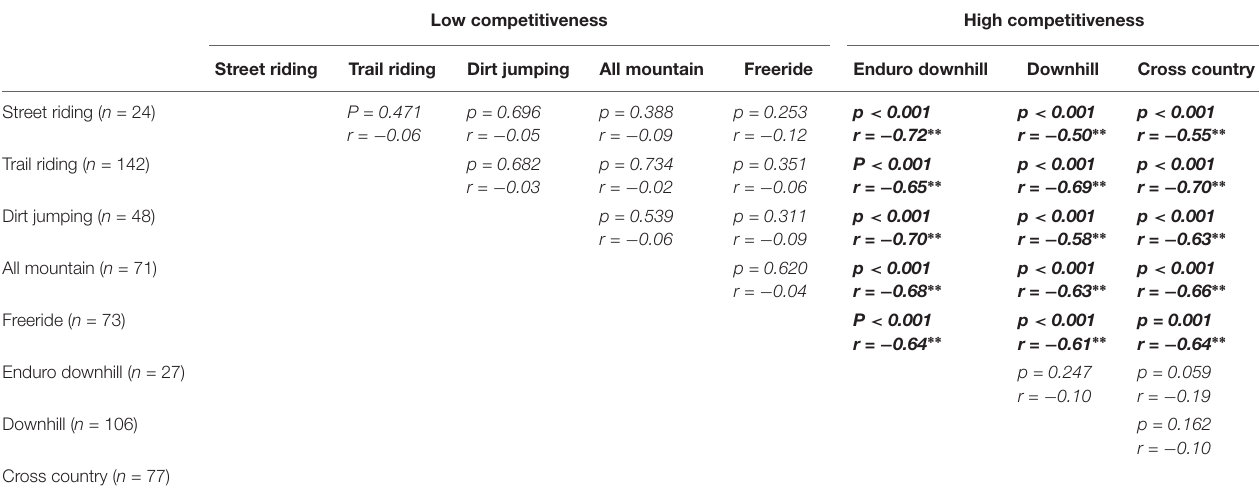
TABLE 3 | Comparative association of competition between riding styles.